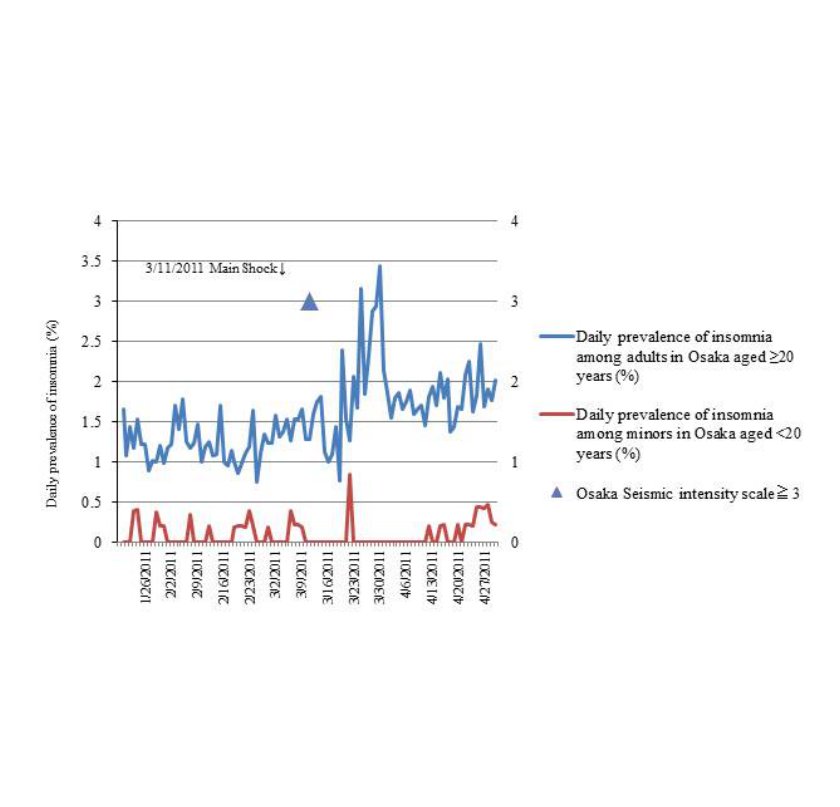
Figure 3. Prevalence of insomnia in Osaka. The prevalence of insomnia among adults increased after the earthquake. The prevalence of insomnia among minors remained approximately the same as that before the